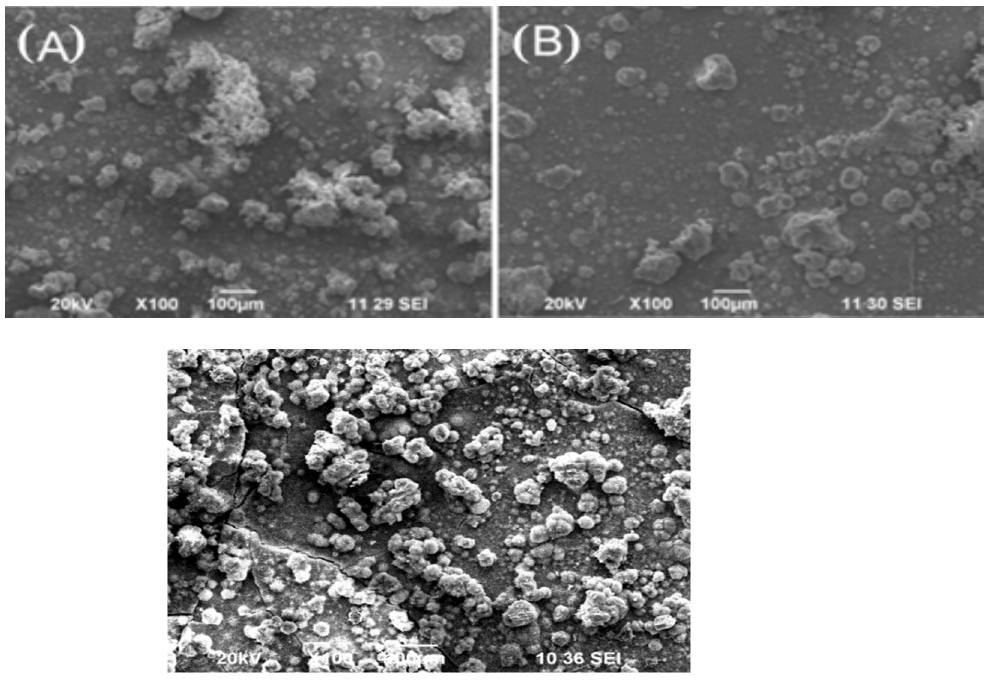
Figure 9. Surface morphology of the corrosive treated Zn/CuO ( A ) and Zn/NCs ( B ) hybrid coatings; ordinary zinc ( below ).